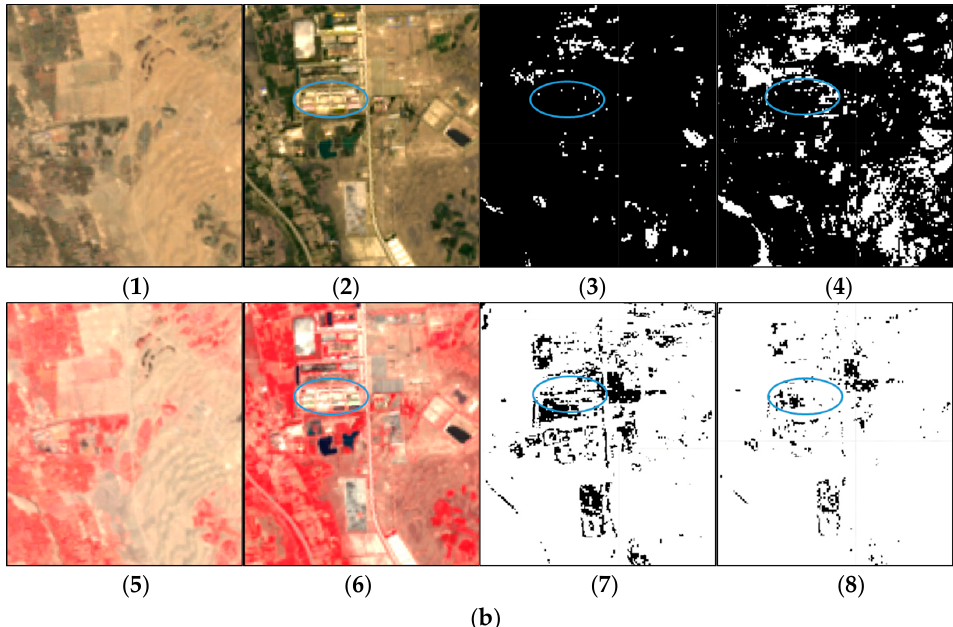
Figure 4. Threshold selection of possible change region. In figure ( a,b ), ( 1 ) the detail of true color image in 2010, ( 2 ) the detail of true color image in 2019, ( 3 ) the possible change area obtained when the threshold is the mean value add 0.5 standard deviation, ( 4 ) the possible change area obtained when the threshold is the mean value add 0.25 standard deviation, ( 5 ) the detail of false color image in 2010, ( 6 ) the detail of false color image in 2019, ( 7 ) the possible change area obtained when the threshold is the mean value, ( 8 ) the possible change area obtained when the threshold is 0.5 mean value.